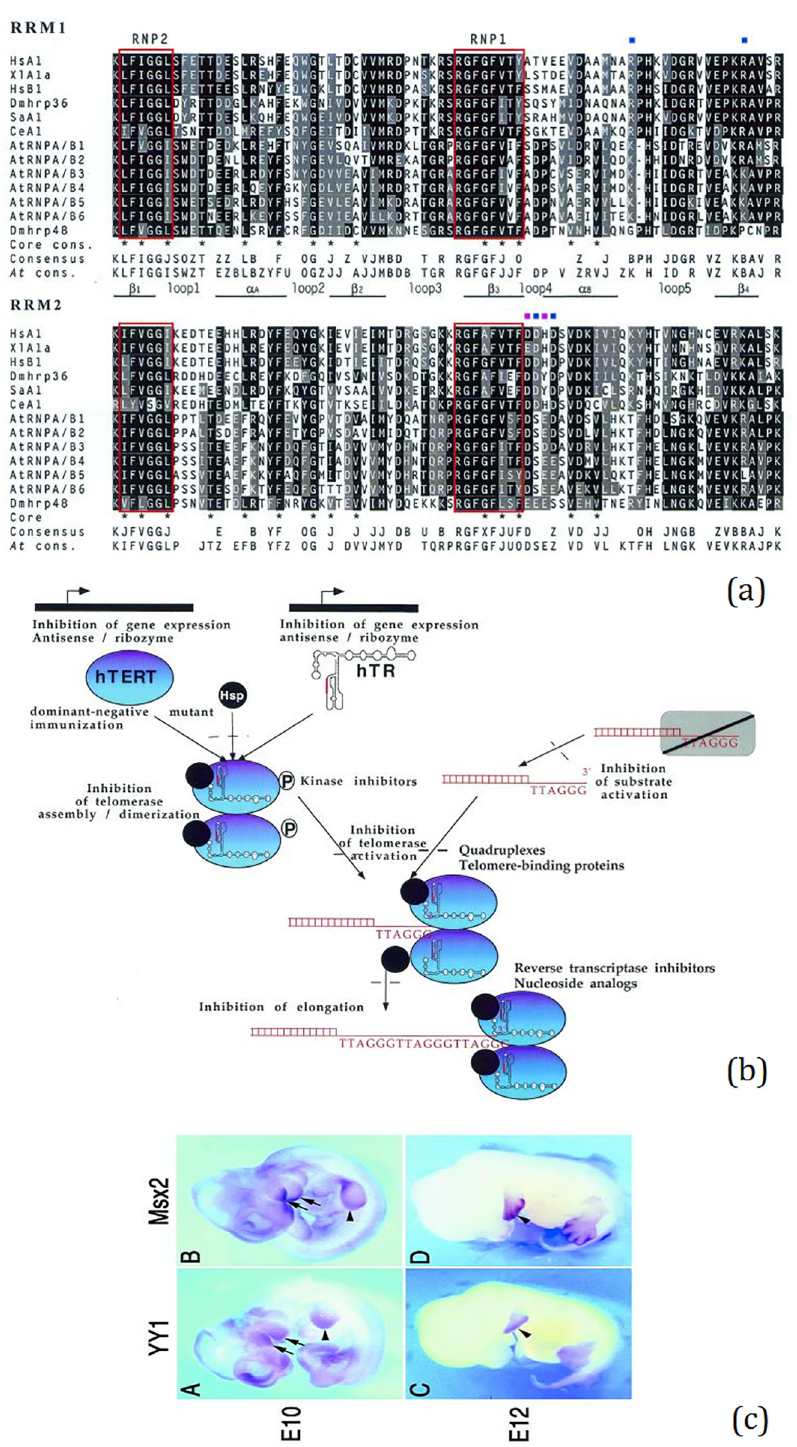
Fig 1. Representative biomedical figures and their texts. (a) experimental results (gene sequence), (b) research models, and (c) biomedical objects.